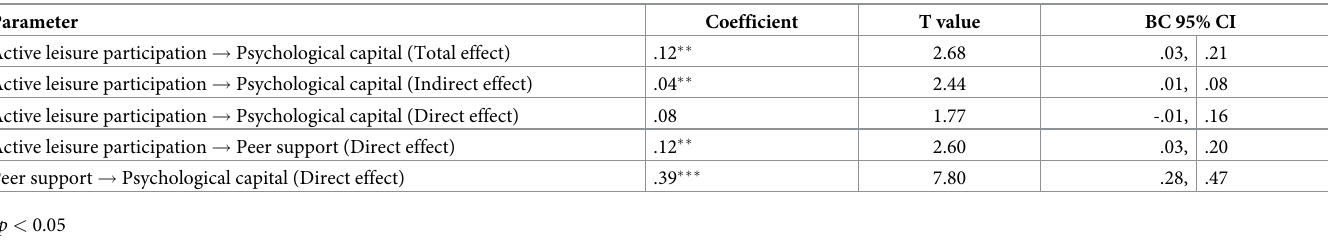
Table 4. Path coefficients of direct effects and indirect effects.